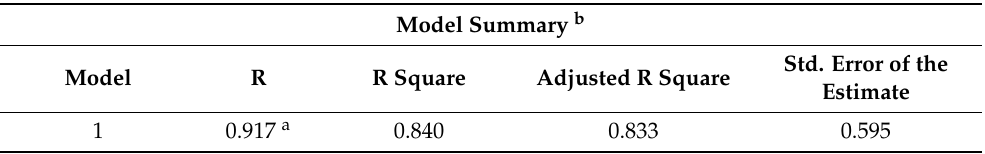
Table 6. Linear regression for the variables of the study.